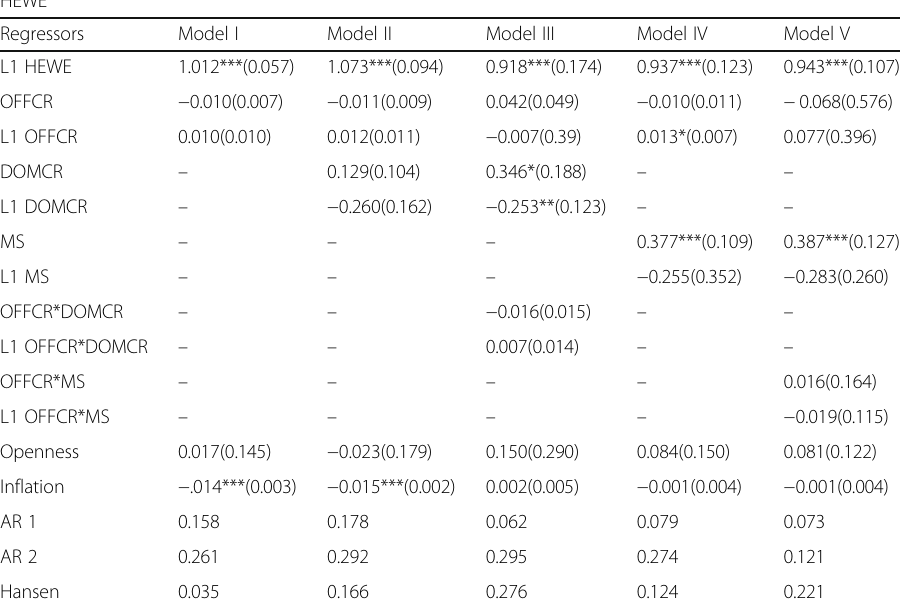
Table 3 Dynamic panel data estimation, one-step system GMM: Interaction effect of OFFCR and FD on HEWE HEWE